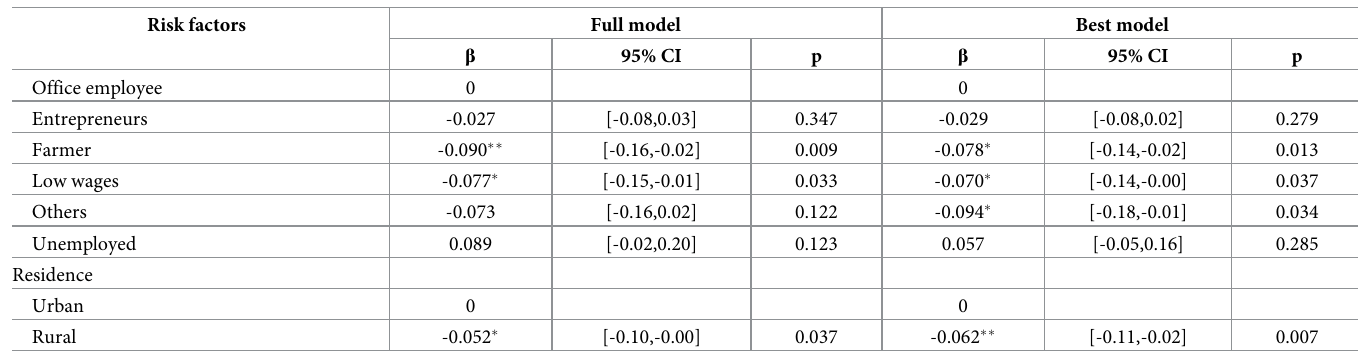
1.19; p = 0.023) stunting, but not severe stunting. Children who had fathers with smoking behavior had a higher risk for moderate (RR = 1.07, 95%CI 1.01 to 1.13; p = 0.016) and severe (RR = 1.08, 95%CI 1.02 to 1.15; p = 0.002) stunting. In addition, socioeconomic factors related to stunting were household wealth quintile, number of household members, maternal education, maternal and paternal occupation, and rural or urban residence. The analysis showed that quintiles of lower wealth were associated with mild, moderate, and severe stunting. Children from the poorest quintile had a 1.77-fold